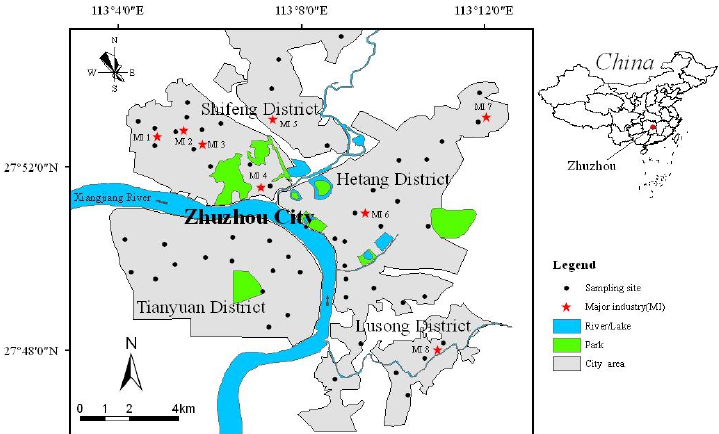
Figure 1. Sketch map showing the study area with sampling locations of street dust and the major industries in Zhuzhou city.